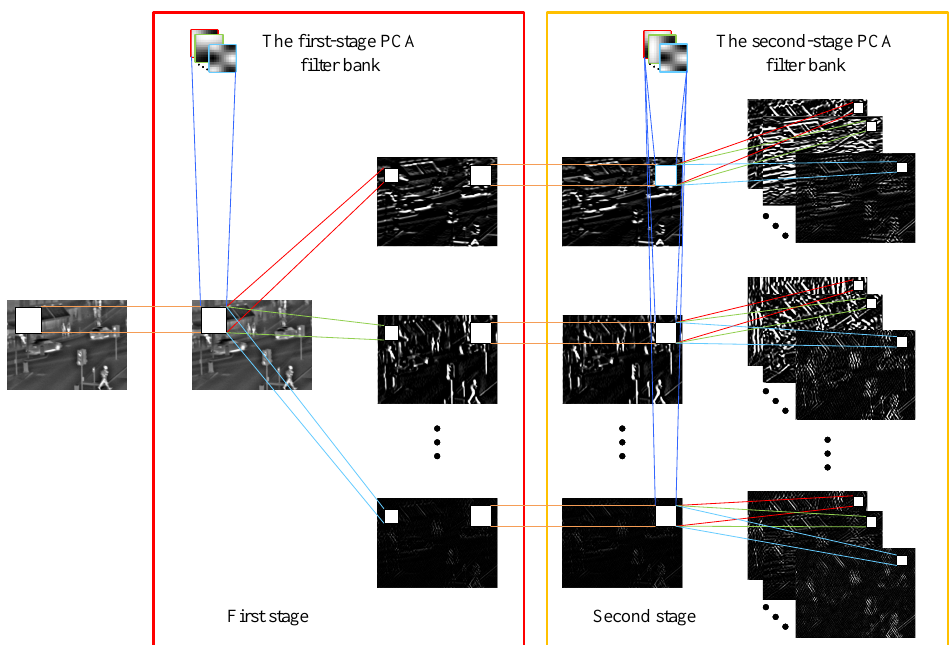
Figure 2. The PCANet model used in the proposed fusion